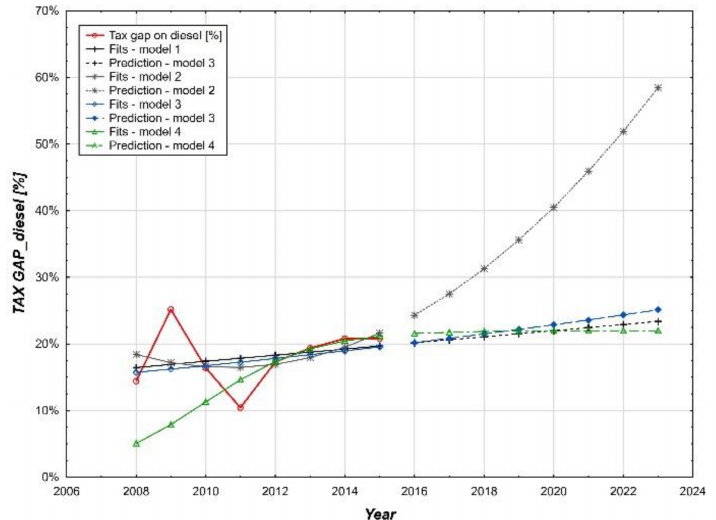
Figure 14. Prediction of the value of TAX GAP diesel (%) in the years